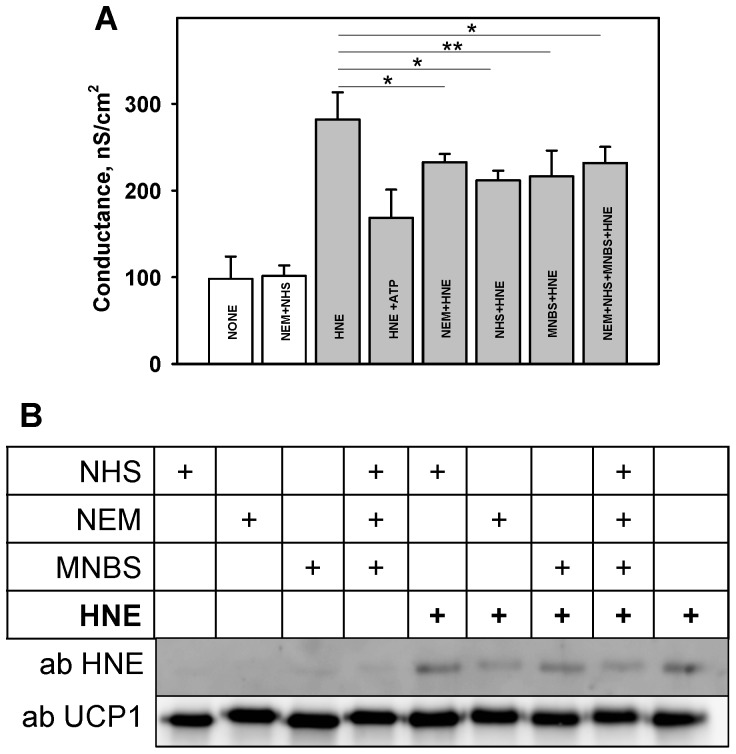
Analysis of HNE-mediated UCP1 modification.A. Membrane conductance decrease in the presence of Cys, Lys, and His blockers. Membranes were made from E. polar lipid (1mg/ml) and reconstituted with arachidonic acid (15 mol%) and UCP1 (charge 18, 11.9 µg/(mg of lipid). Bar 1 shows the conductance of the membrane without additives (control). NEM, NHS and MNBS in concentrations of 0.5 µM, 1.3 µM and 0.2 µM respectively were incubated with protein as described in Results. HNE was added in concentration 860 µM (grey bars). Buffer solution contained 50 mM Na2SO4, 10 mM Tris, 10 mM MES, 0.6 mM EGTA at pH 7.5. Data points represent mean ± standard deviation from 3–5 independent experiments. * p<0.05; ** p<0.01. B. Western blot analysis of the UCP1-containing proteoliposomes in the presence of different additives (arachidonic acid, AA; hydroxynonenal, HNE; NEM; NHS; MNBS). Only HNE-modified UCP1 is recognized by HNE antibody.